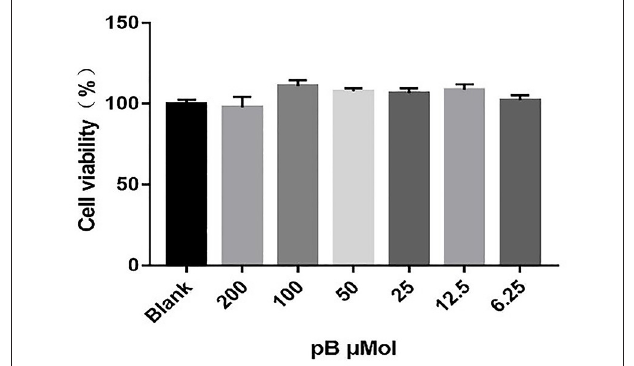
FIGURE 2 | Effects of procumboside B (pB) on the viability of RAW264.7 cells. Data presented are the mean ± SD, n = 6.